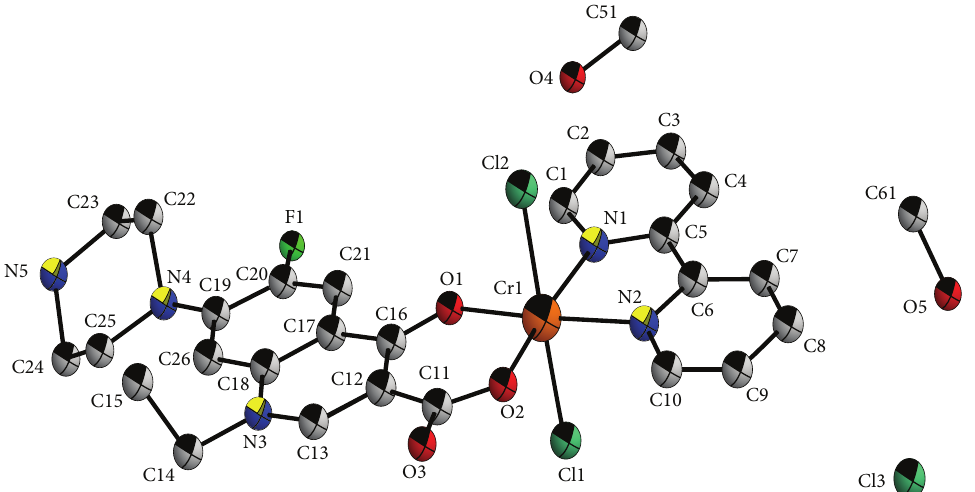
Figure 3: ORTEP diagram (50% probability factor for thermal ellipsoid) of the molecule [Cr(Nor)(Bipy)Cl 2 ]Cl ⋅ 2CH 3 OH; color code: carbon: grey; nitrogen: blue; oxygen: red; fluorine: green; chlorine: dark green; chromium: orange (only hydrogen atoms were not shown for